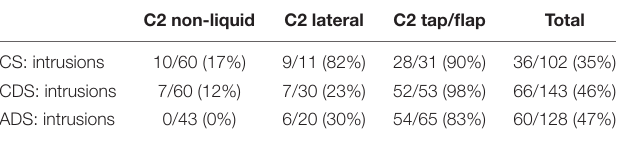
TABLE 4 | The number of instances with a vowel intrusion and the number of clusters measured in the three data sets, by C2 category. C2 non-liquid C2 lateral